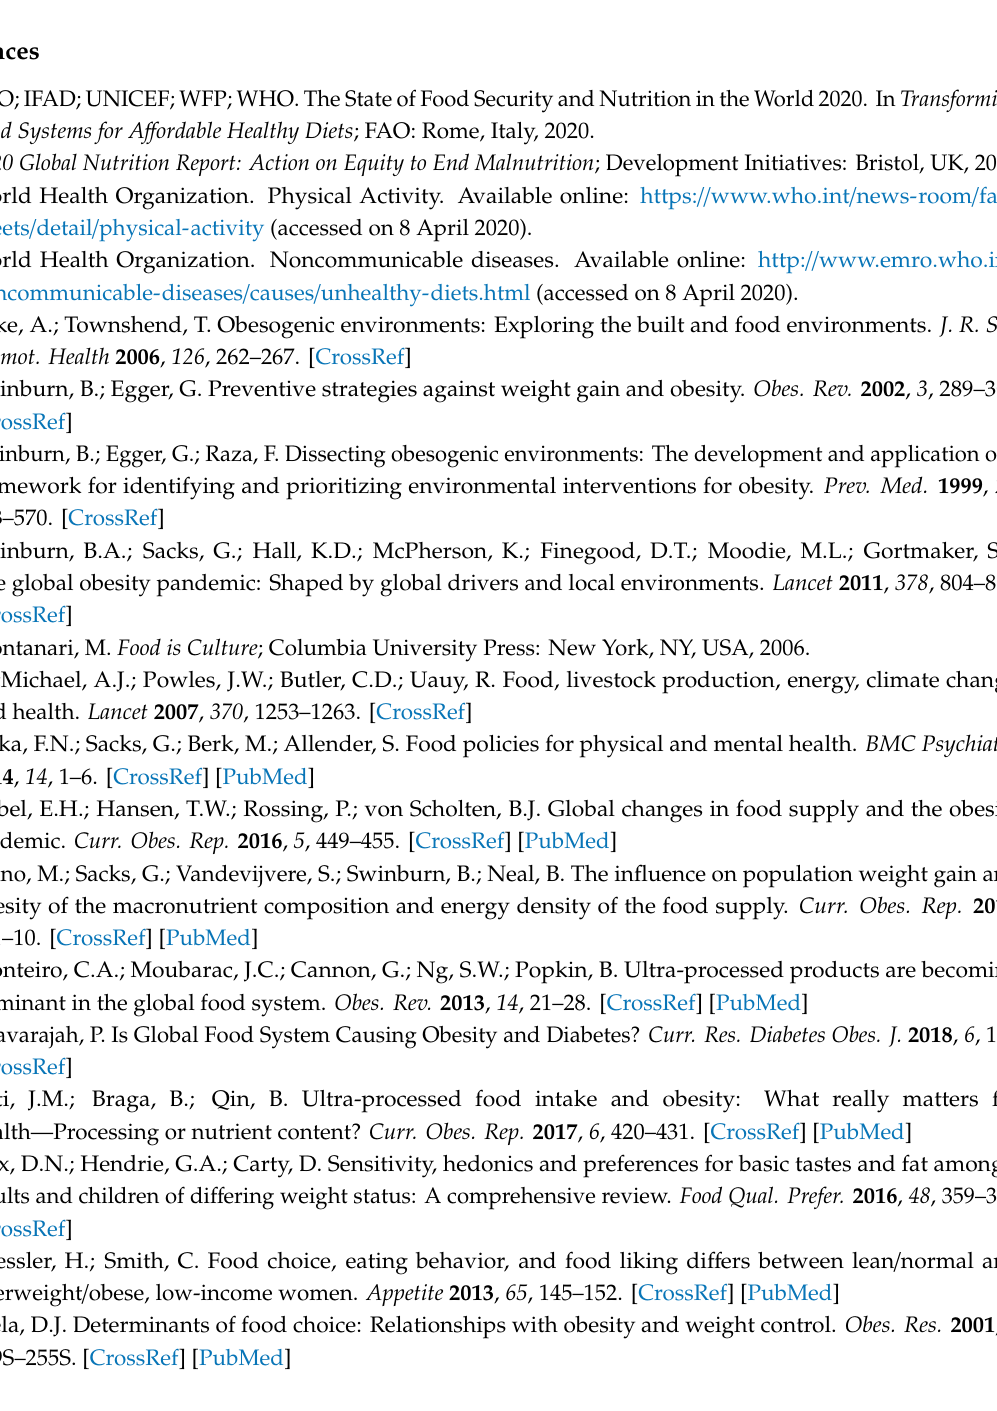
Table S1: Factors included in the conceptual models of food choice. Table S2. Direction of influence of factors a ff ecting food choices based on publications with empirical